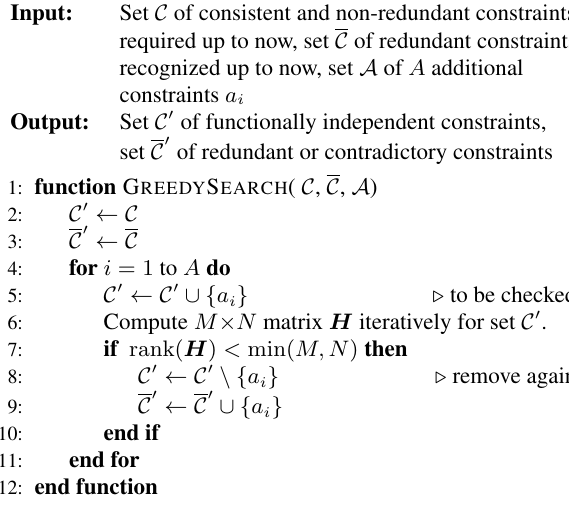
Table 2. Greedy search for functionally independent